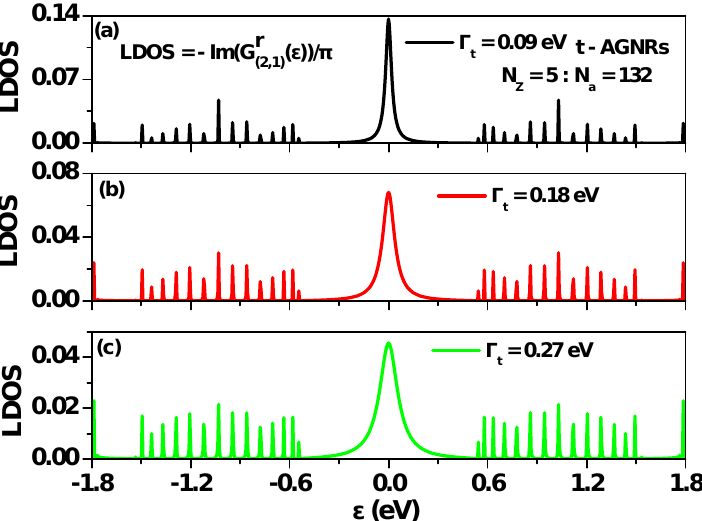
Figure A4. Local density of states of a t-AGNR with ( N z , N a ) = (5,132) as a function of ε for various tunneling rates at site